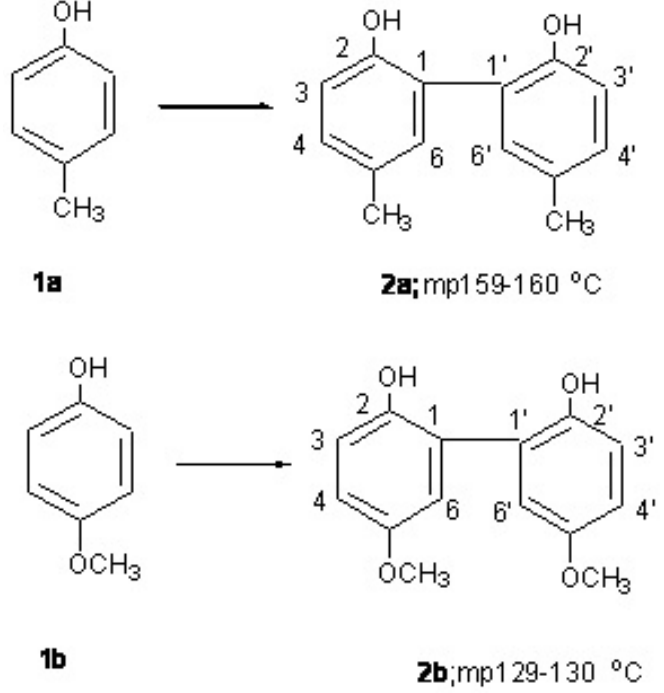
Figure 1. Dimer formation derived from p -cresol ( 1a ) and p -methoxyphenol ( 1b